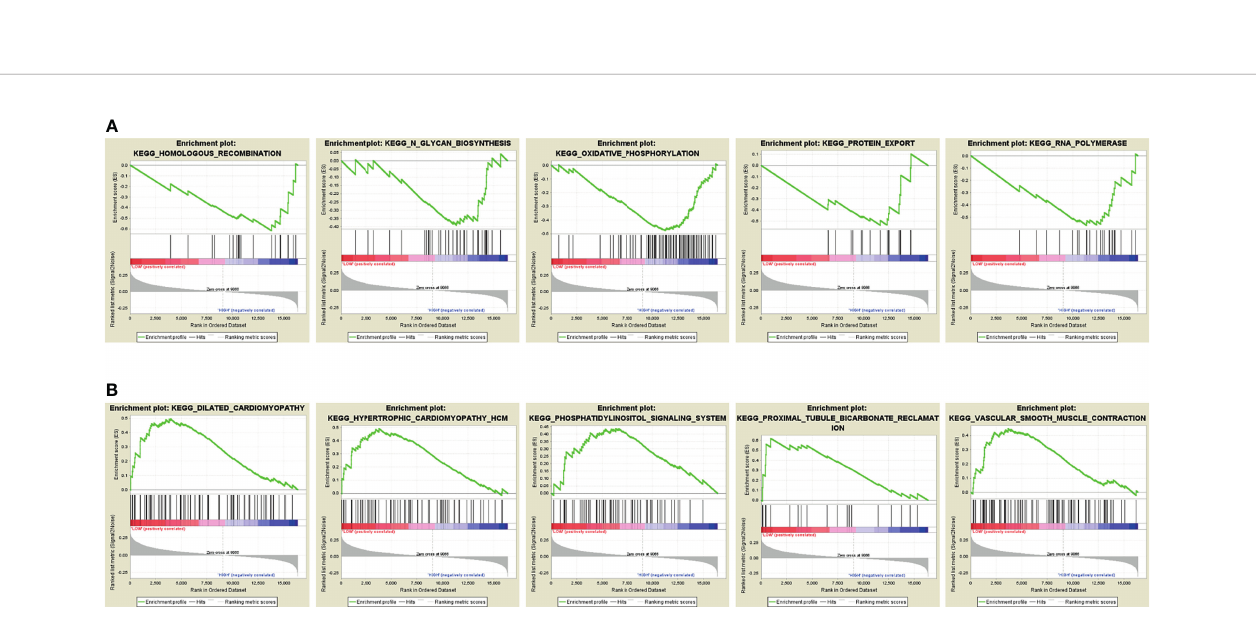
FIGURE 5 | Gene Set Enrichment Analysis (GSEA). (A) GSEA shows a signi fi cant enrichment of cancer-related pathways in the high-risk group based on the training cohort. (B) GSEA shows a signi fi cant enrichment of cancer-related pathways in the low-risk group based on the training cohort.